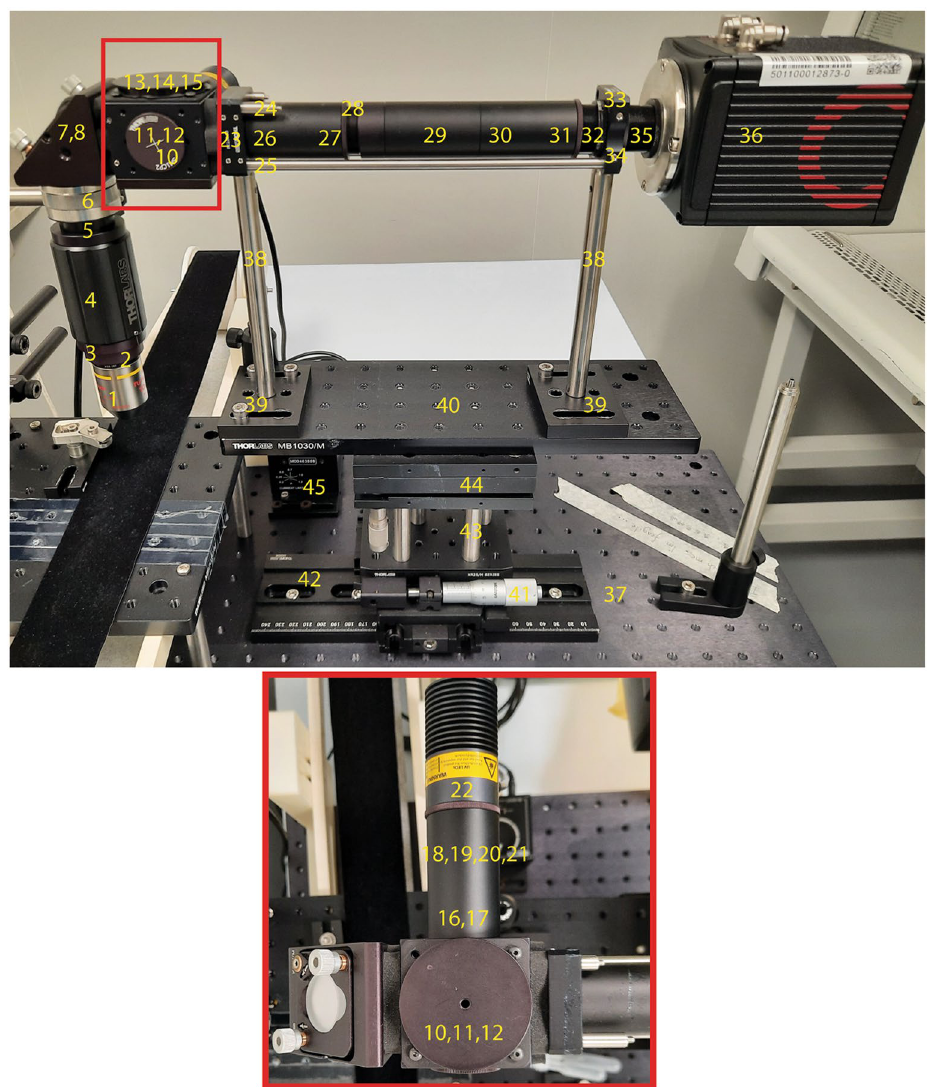
Figure 2. Microscope assembly used for bimodal recording. (Top) Numbers indicate corresponding description of parts in Table 1. (Bottom) A magnified top view of the red square in